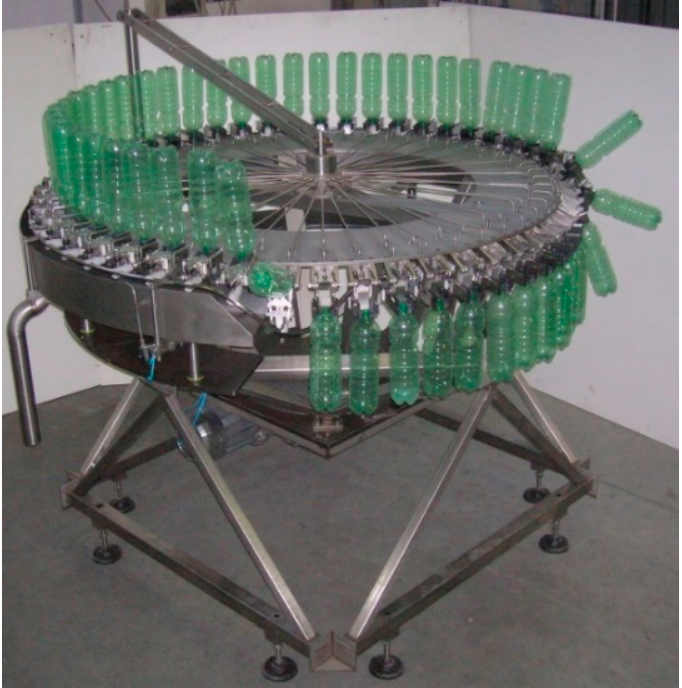
Figure 2. Bottle sterilizer machine with the base developed in [21]. External protection is not present in order to display the base.